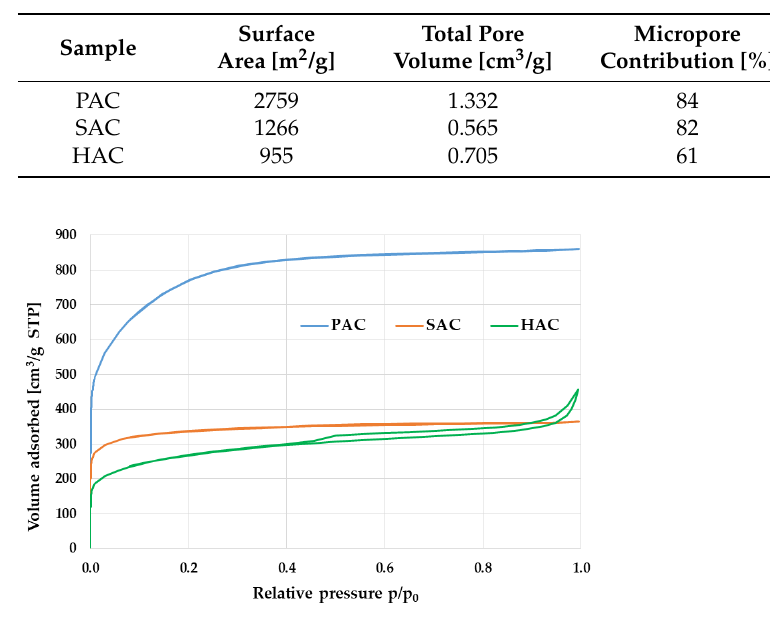
Table 3. Textural parameters of the activated biocarbons obtained.